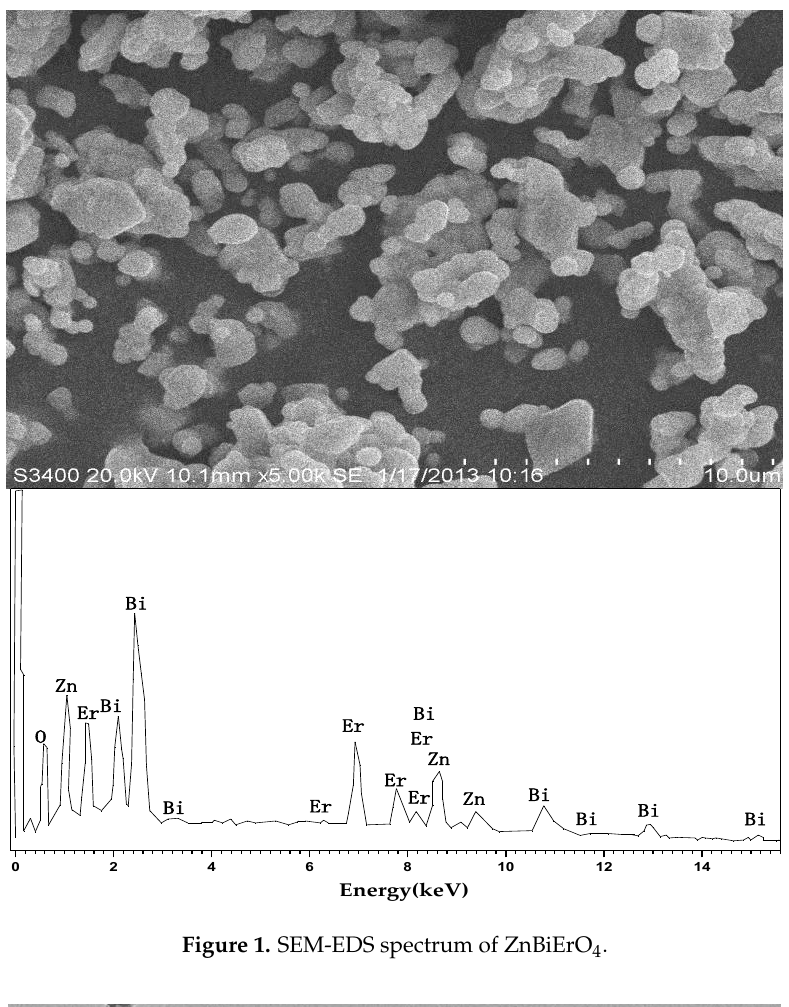
Figure 1. SEM-EDS spectrum of ZnBiErO 4 .